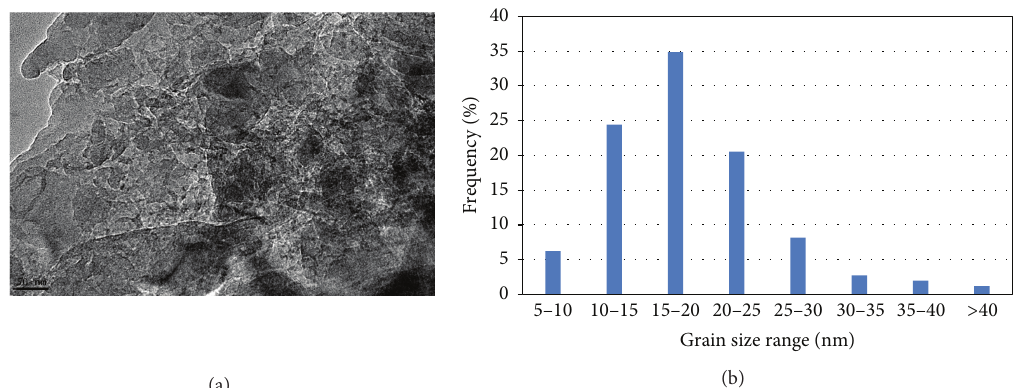
Figure 4: Cryomilled Al powder for 7 hrs: (a) TEM bright-field image and (b) grain size distributions for the TEM micrograph in (a).